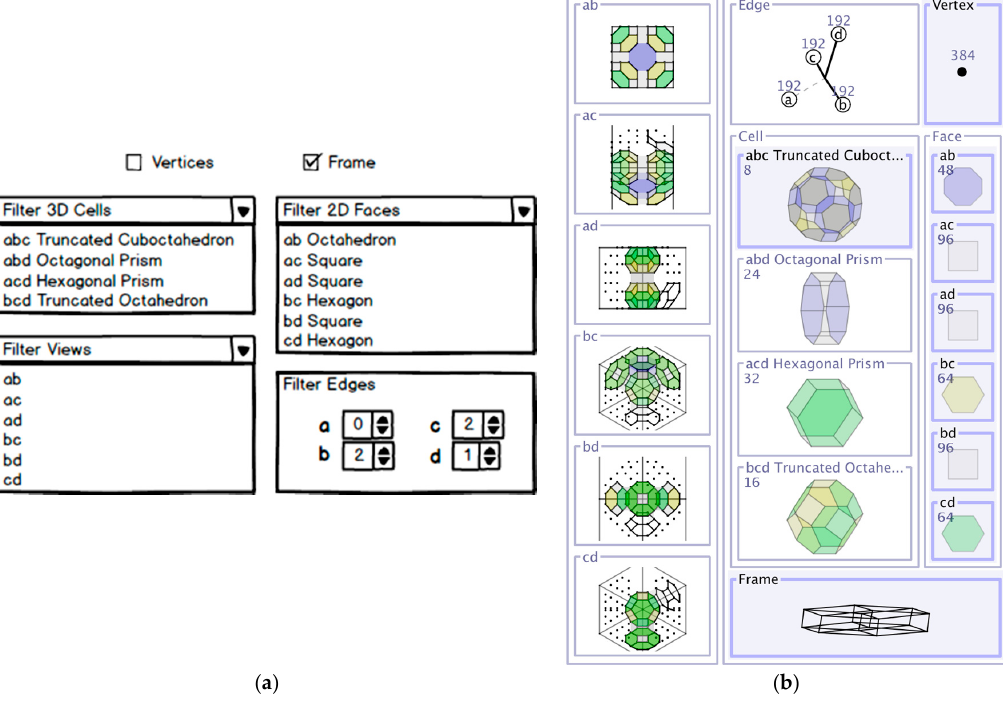
Figure 8. A common method of making action possibilities visible: menu lists using textual labels ( a ). In Polyvise, action possibilities are made visible by providing textual labels along with visualizations of the components that are the intended targets of the actions ( b ).